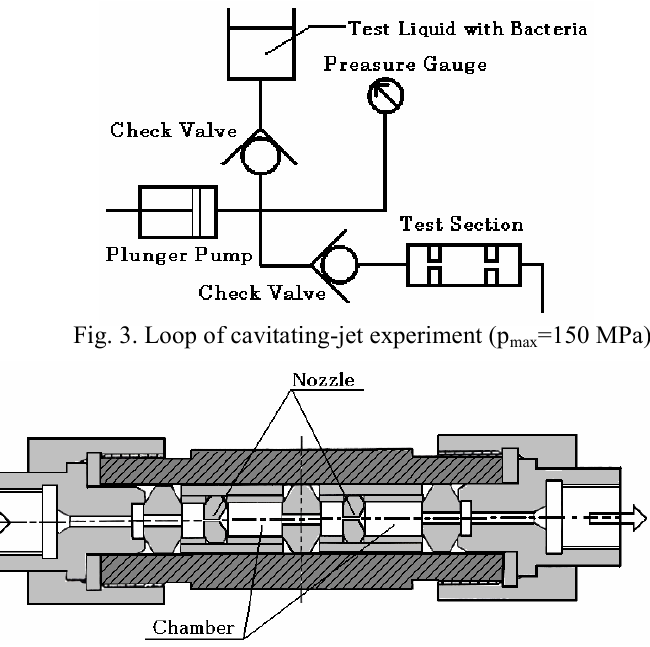
Fig. 4. Test section with two nozzles (diameter of nozzle: 0.10-0.31 mm